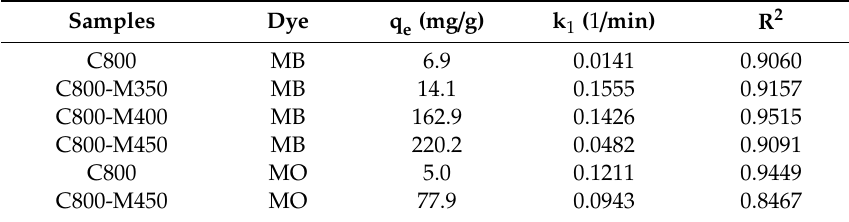
Table 4. Regression results from pseudo-first-order kinetic model.